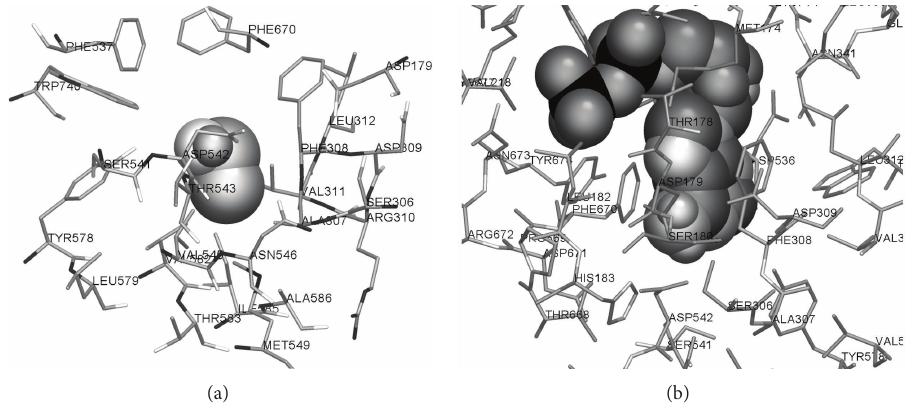
Figure 2: Results of the docking of ethanol (a) and ADP (b) to the model of rat liver phosphofructokinase. Ligands are shown by spheres, interacting amino acid residues are shown by cylinders, and other amino acid residues of the protein are hidden.